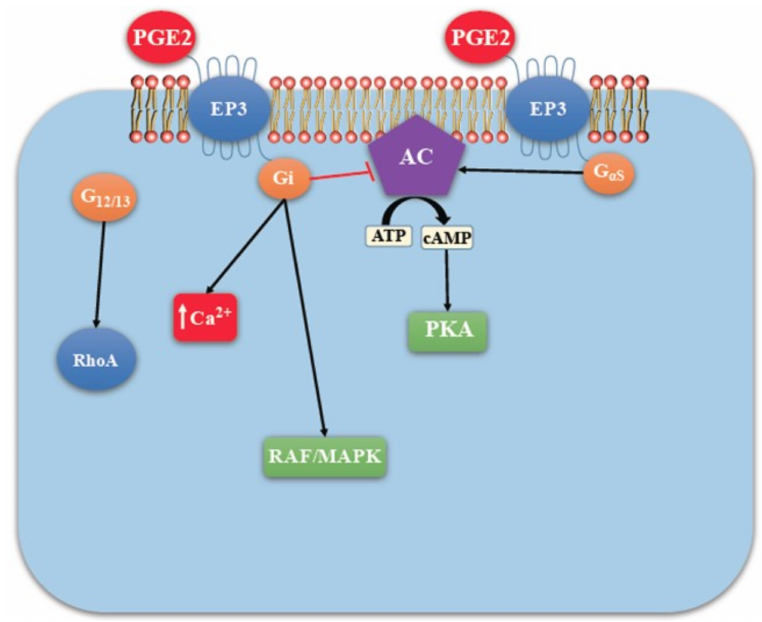
Figure 6. EP3 mediated signaling (adapted with kind permission from O’callaghan, G.; Houston, A.; 2015; reference [13]). EP3 has multiple isoforms, most of which are coupled with the inhibitory G-protein Gi that acts by inhibiting AC-cAMP-PKA pathway. Those coupled with Gs stimulate AC-cAMP-PKA pathway. Those coupled with G 12/13 are involved in Rho family GTPase signaling utilized in cell migration by cytoskeleton